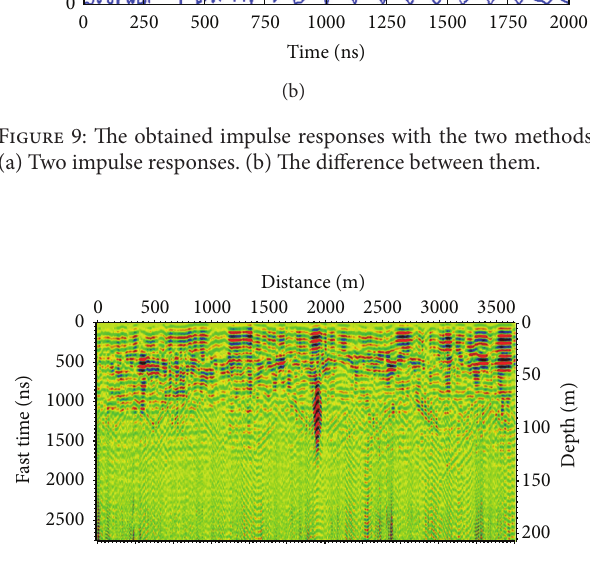
Figure 10: The detection result with the low-frequency coded GPR, and the dielectric constant is